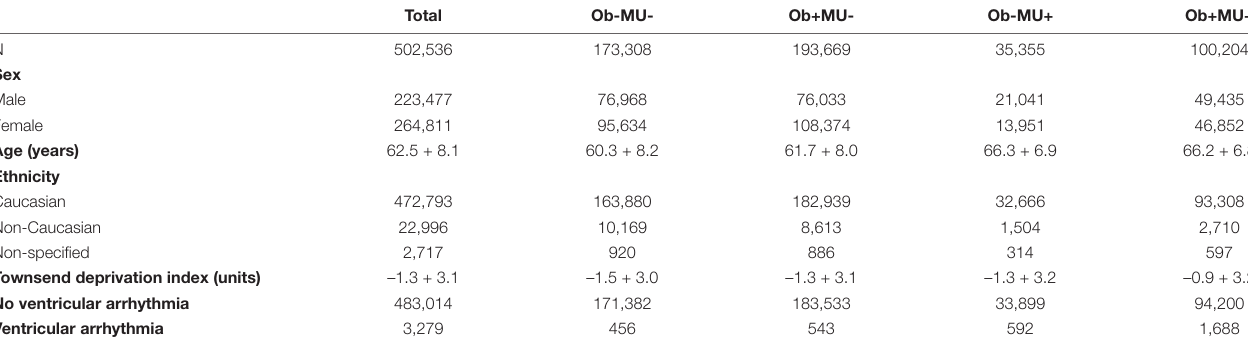
TABLE 2 | The characteristics of the UK Biobank participants stratified by clinical phenotypes in whom risk of ventricular arrhythmias was